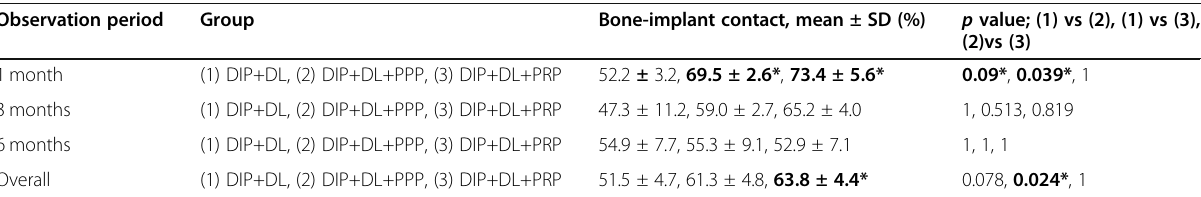
Table 1 3D bone-implant contact ratio of control (DIP+DL) and test groups (DIP+DL+PPP, and DIP+DL+PRP) at different follow-up time-points using micro-CT (* p <